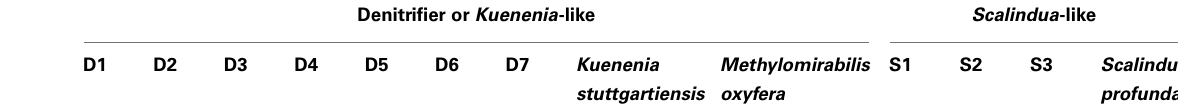
TableA1 | Range of similarities (%) between the different clusters identified in the NirS phylogenetic trees, based on amino acid sequences.